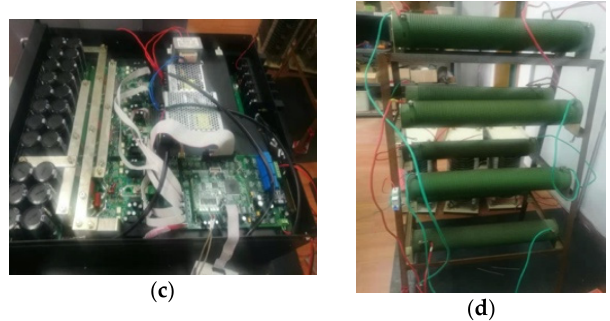
Figure 8. The experiment setup: ( a ) the main circuit board; ( b ) DSP; ( c ) the rectifier; ( d ) the load. When the DC side voltage is set as 400 V in the non-reconfigurable inverter that is faulty, in phase a, phase b and phase c, the experimental results are shown in Figure 9. Figure 9a1–a3 show output voltages corresponding, respectively, to faulty phase a, b and c with the vertical axis 100 V/grid and horizontal axis 10 ms/grid. Figure 9b1–b3 show output currents corresponding, respectively, to faulty phase a, b and c with the vertical axis 30 A/grid and horizontal axis 10 ms/grid. Figure 9c1–c3 show the voltage deviations between output voltages and reference voltages corresponding, respectively, to faulty phase a, b and c with the vertical axis 50 V/grid and horizontal axis 10 ms/grid. This can be seen from the waveforms being distorted seriously and three-phase imbalance when the inverter is operating in a faulty state. The voltage deviations between output voltages and reference voltages are too large.